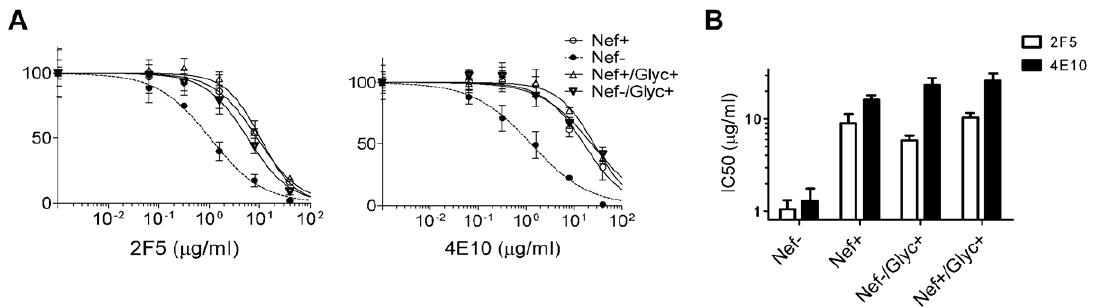
Figure 8. MoMLV Glycogag, like Nef, increases HIV-1 resistance to 2F5 and 4E10. Comparison of the activity of Nef and MLV Glycogag on HIV-1 neutralization by MPER targeting nAbs (A) and IC50 values (B). Nef-positive and Nef-defective HIV-1 NL4-3 pseudotyped with Env JRFL were neutralized by 2F5 and 4E10. As indicated, Glycosylated Gag or an empty vector control were expressed in trans in producer cells. Neutralization was performed three times independently. Shown are the mean values and SD.